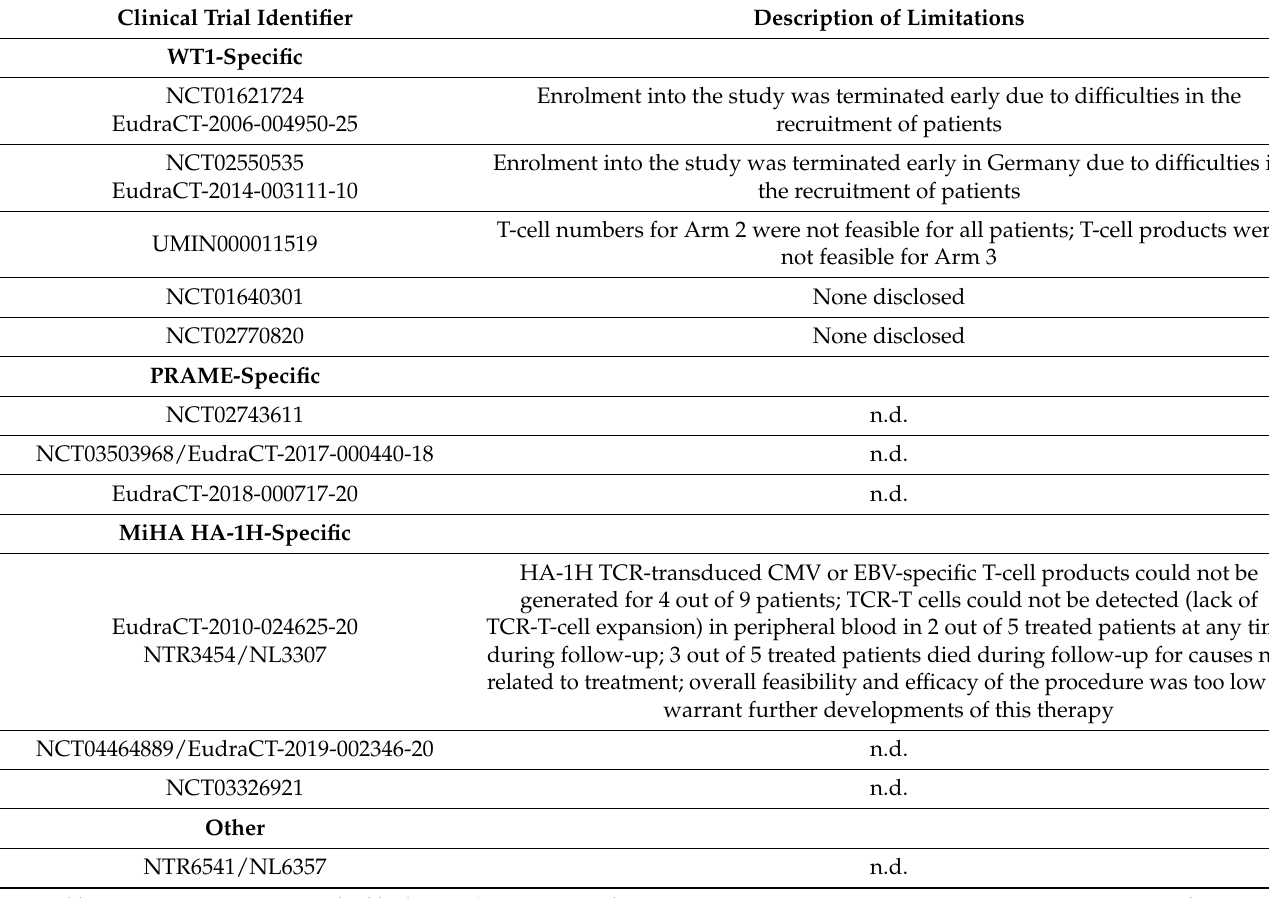
Table 5. Limitations of clinical trials using TCR-T cells for